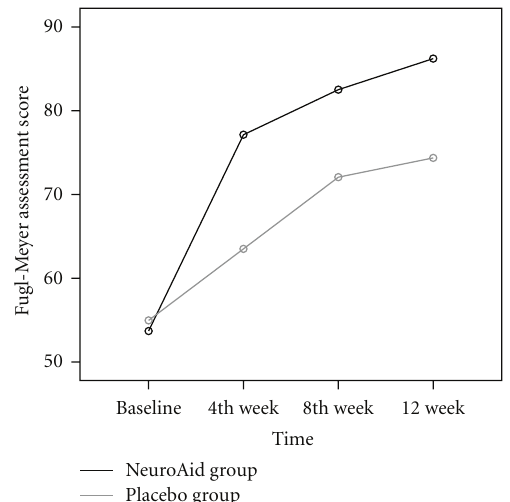
Figure 2: FMA scores in two groups at baseline, 4, 8, and 12th week (repeated measure analysis). P value for groups = .003; P value for time < .0001; P value for interaction between groups and time for 3 times after intervention =